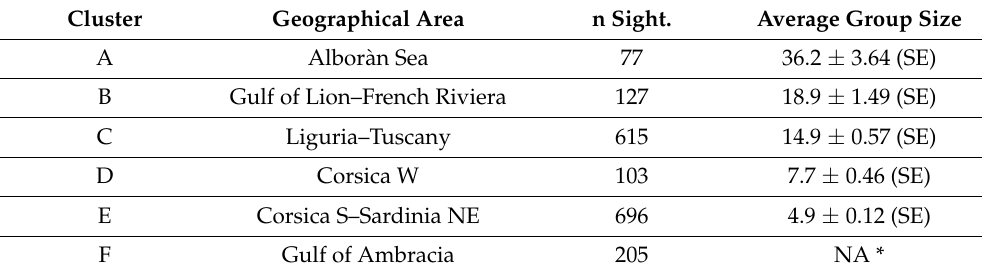
Table 6. The average group size (total number of individuals per sighting) in the different clus- ters/geographical units. In the third column the sample size (number of sightings) on which the average was calculated (n sight.).